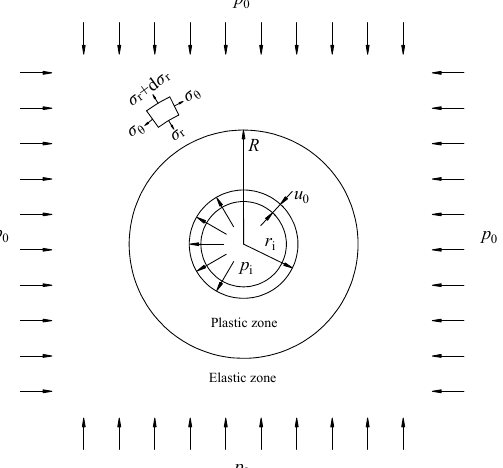
Figure 1. Elastic-plastic analysis model of circular roadway. p 0 : uniform in situ stress, p i : uniform support force, u 0 : the displacement of the roadway wall, σ r : radial stresses, σ θ : tangential stresses, r i : the excavation radius of the roadway, R : the radius of the plastic zone of the surrounding rock.